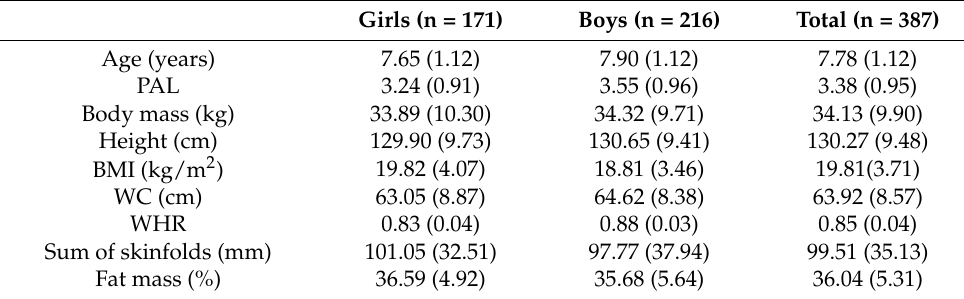
Table 1. Basal characteristics of the sample (mean and standard